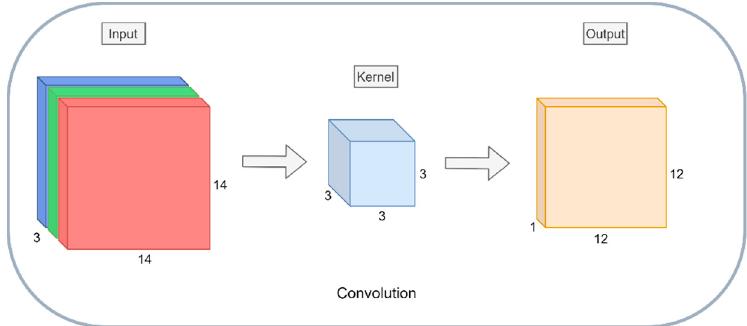
Figure 2. Example of operation of traditional convolution performed on an image as input of dimensions 14 × 14 × 3, with one kernel of dimension 3 × 3 × 3.